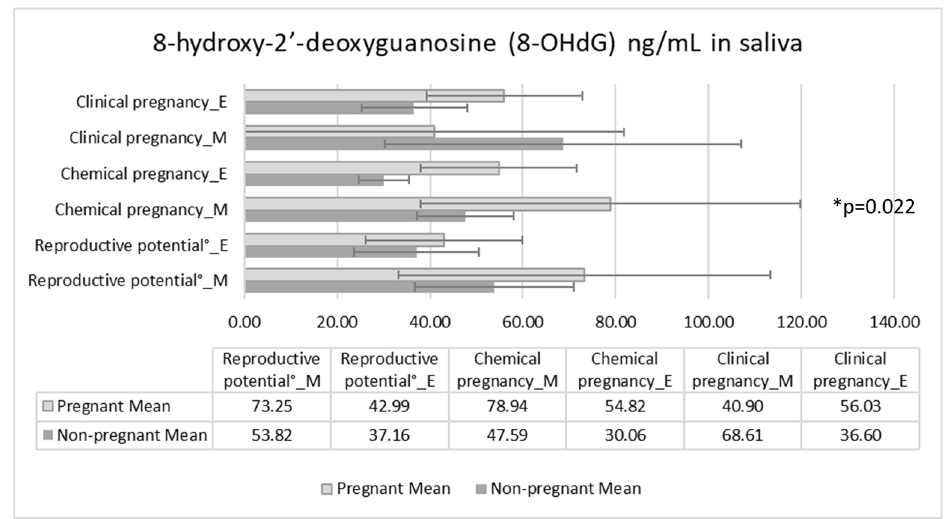
Figure 2. Differences between the 8-hydroxy-2 (cid:48) -deoxyguanosine (8-OHdG) ng/mL levels in patients undergoing IVF using saliva samples. E: evening, M: morning, number of matured oocytes over 6. * p < 0.05.